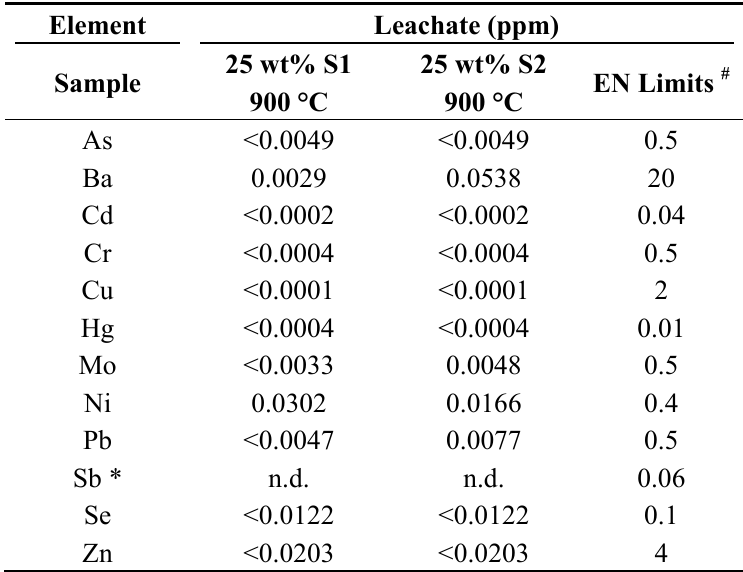
Table 3. Chemical analysis of the leachate of samples subjected to Toxicity Control Leaching Procedure (TCLP) testing (EN, European standard; * data not determined; # Liquid/Solid ratio=10 liters/Kg